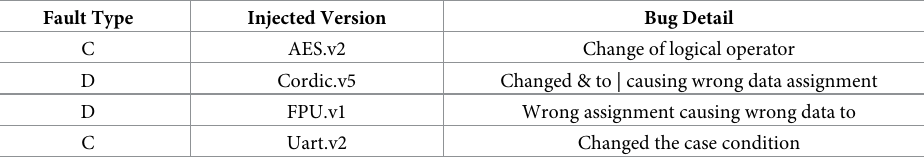
Table notes Phasellus venenatis, tortor nec vestibulum mattis, massa tortor interdum felis, nec pellentesque metus tortor nec nisl. Ut ornare mauris tellus, vel dapibus arcu suscipit sed.